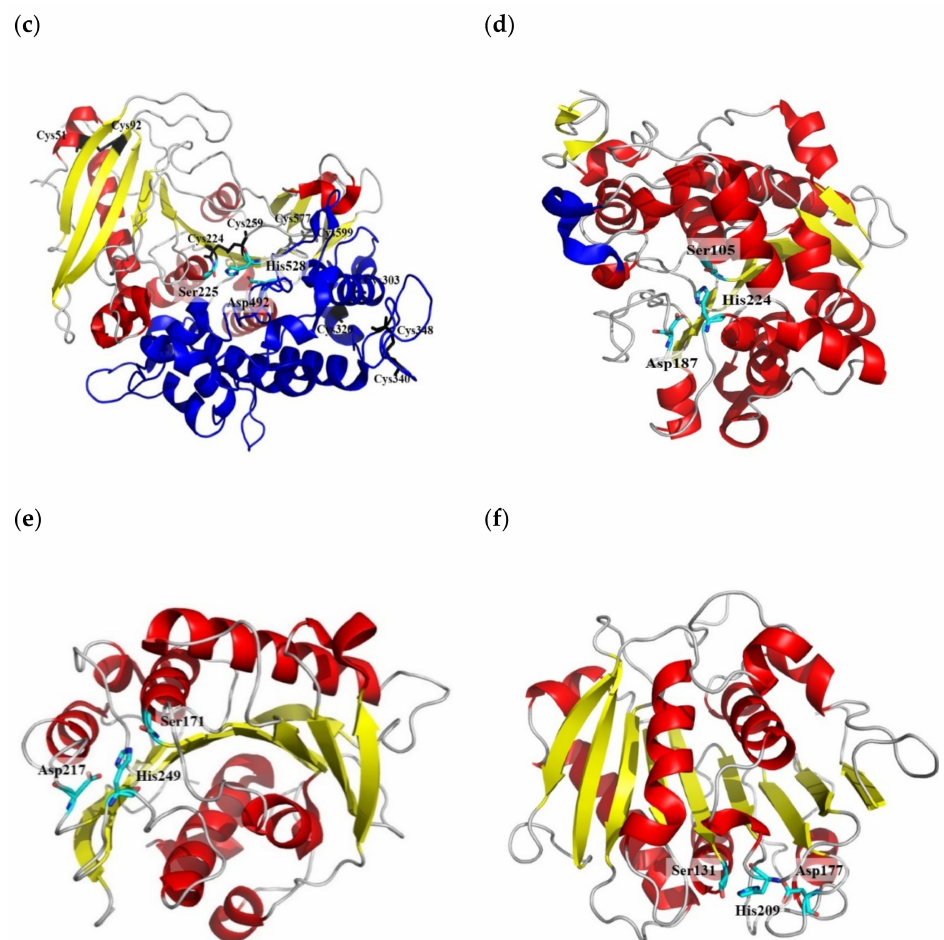
Figure 2. The three-dimensional protein folds of the different hydrolases that reportedly degrade PET ( a ) T. fusca cutinase structure with one disulfide bond (Cys241-Cys249) (PDB ID: 4CG3); ( b ) I. sakaiensis Is PETase with two disulfide bonds (Cys239-Cys203, Cys273-Cys289) (PDB ID: 5XJH); ( c ) I. sakaiensis MHETase with a large lid domain and five disulfide bonds (Cys51-Cys92, Cys224- Cys529, Cys303-Cys302, Cys340-Cys348, and Cys-577-Cys599) (PDB ID: 6QGA); ( d ) C. antarctica lipase with a α 5 -helix lid (PDB ID: 4K6G); ( e ) P. aestusnigri carboxylesterase (PDB ID: 6SBN); ( f ) T. halotolerans esterase (GenBank: AFA45122.1). Catalytic triad residues are highlighted in cyan, cysteine residues are presented by black sticks, and lid domains are in blue,